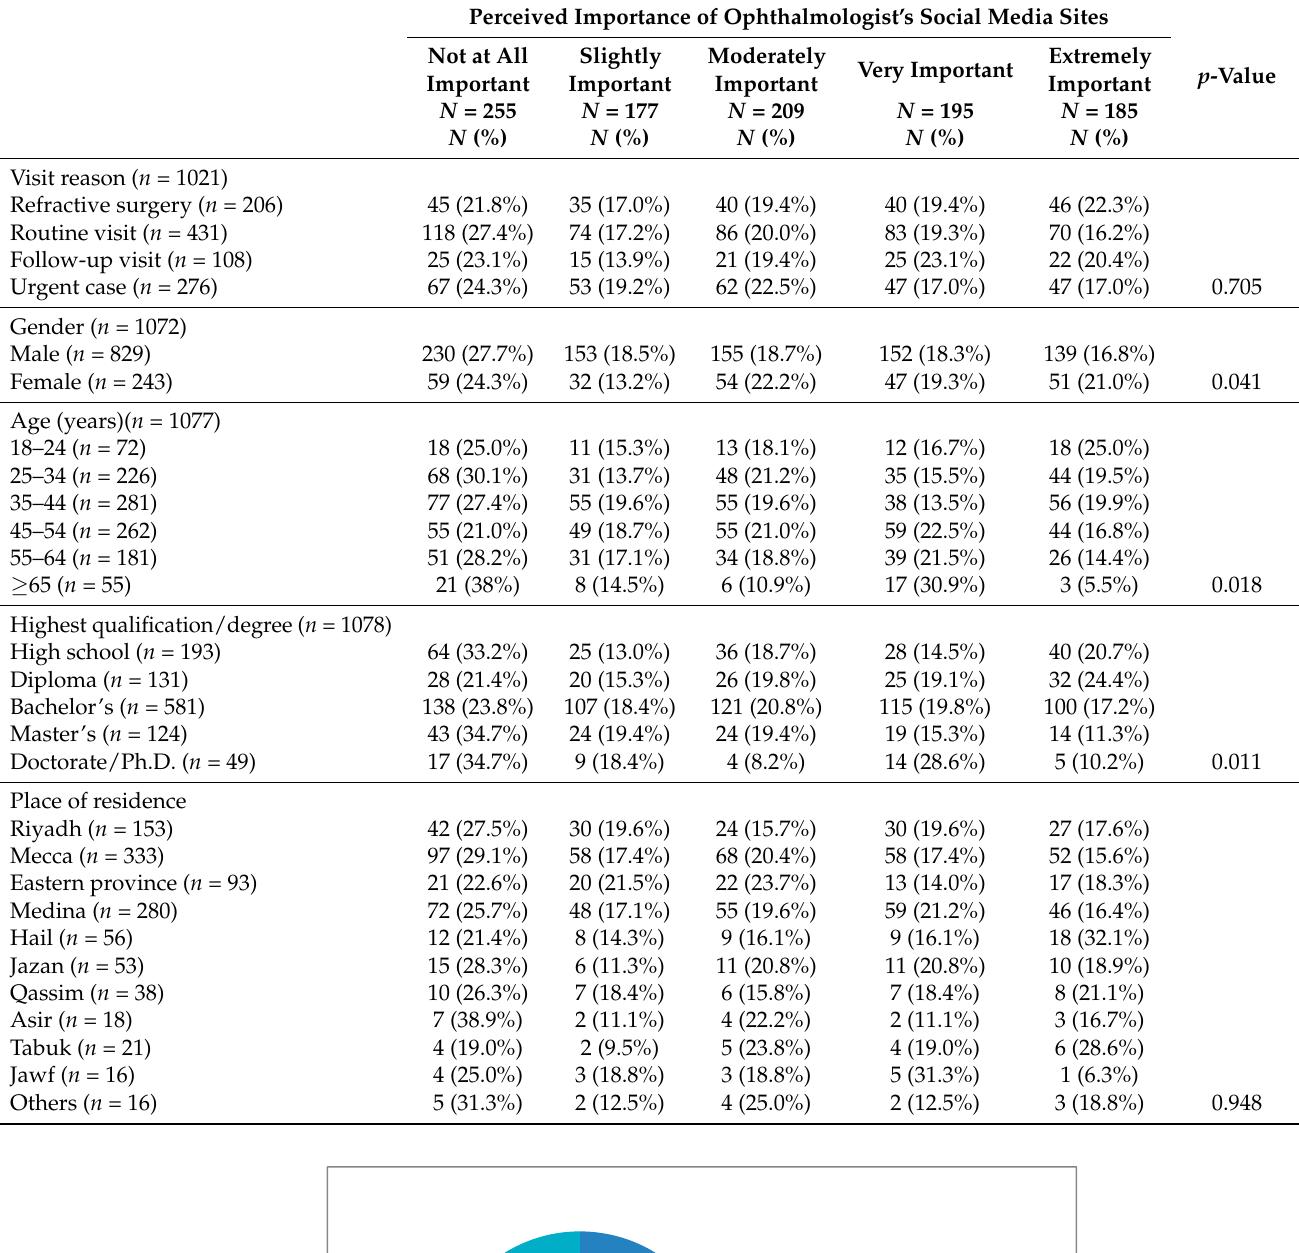
Table 4. Factors associated with perceptions of the importance of ophthalmologists’ social media sites among the participants.